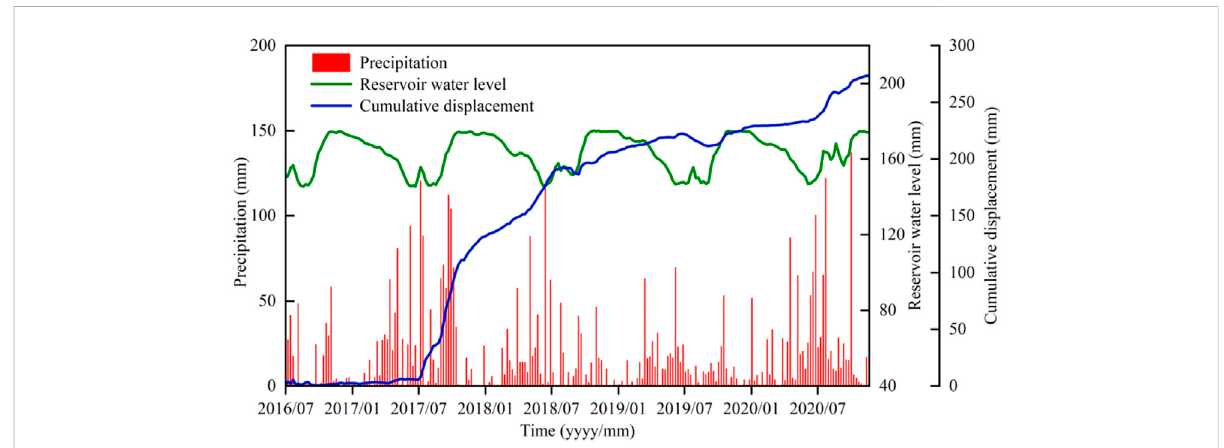
FIGURE 4 Monitoring curve of cumulative displacement, rainfall, and water level of the reservoir area of the